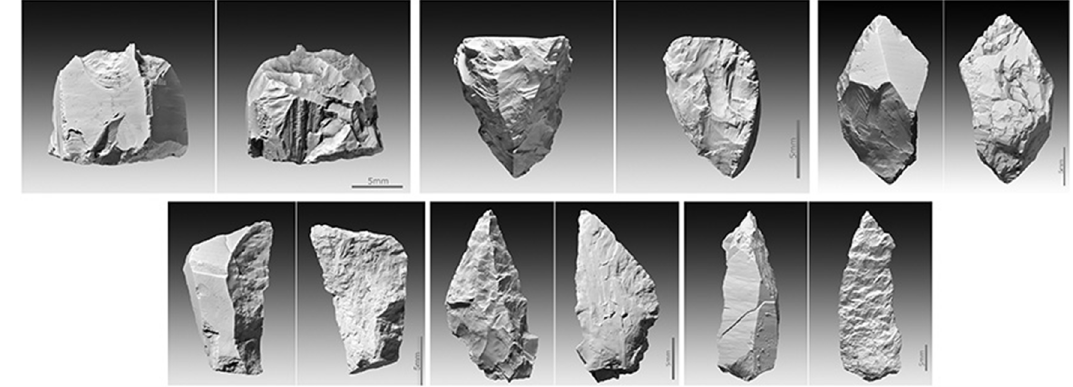
Figure 14: Barca do Xerez de Baixo: the few elongated blanks found at the site made from small volumes of hyaline quartz. Photo, J. P.